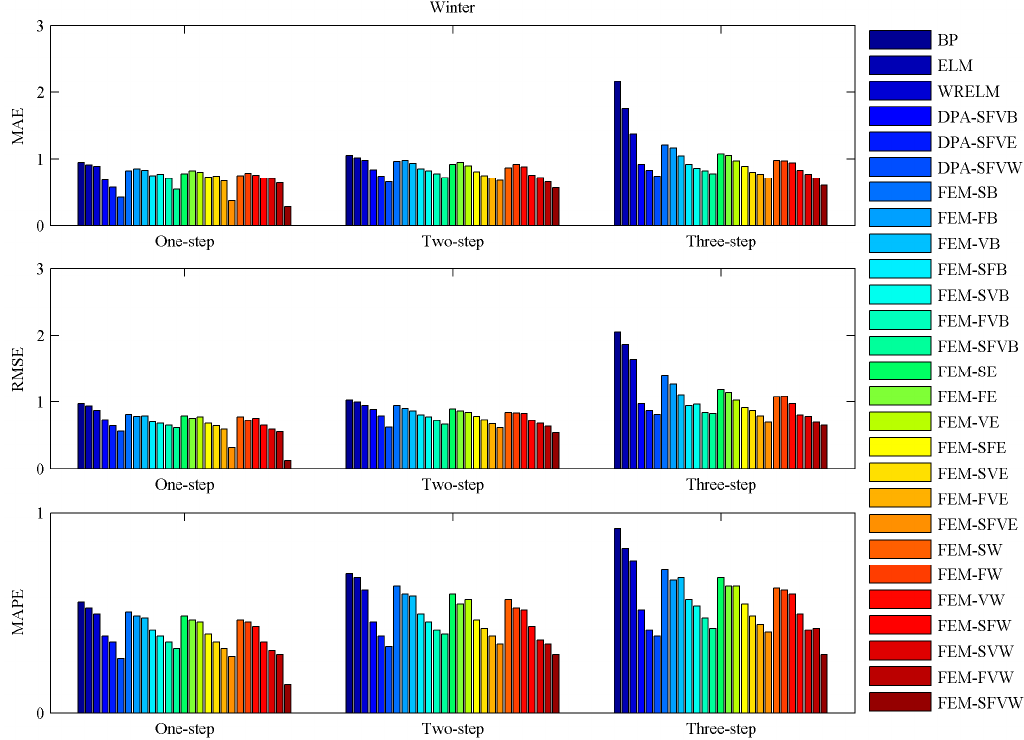
Figure 14. Performance comparison of different models in terms of MAE, RMSE and MAPE in winter.